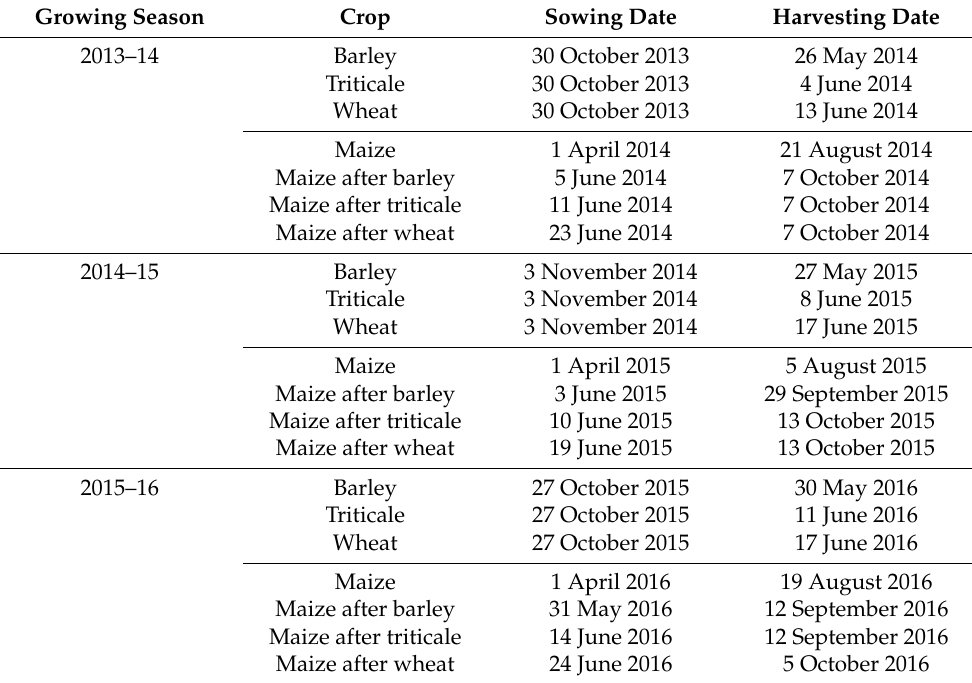
Table 2. Sowing and harvesting dates of the cropping systems in the three growing